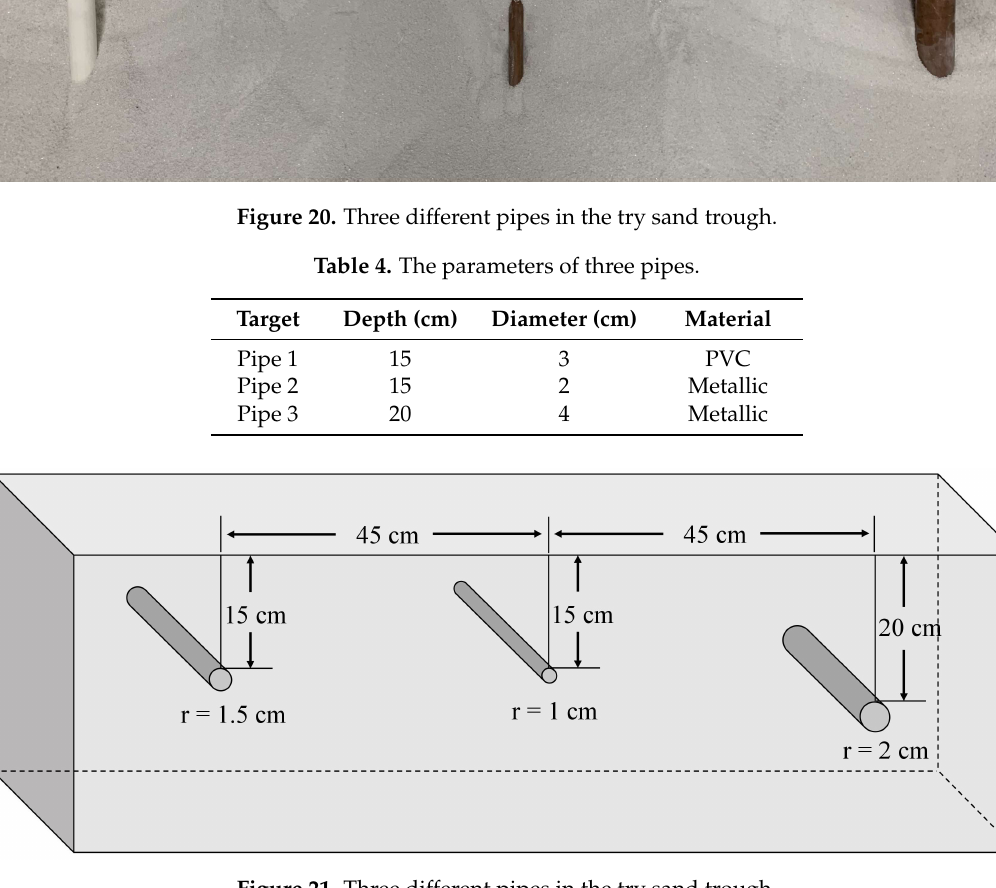
Figure 21. Three different pipes in the try sand trough.